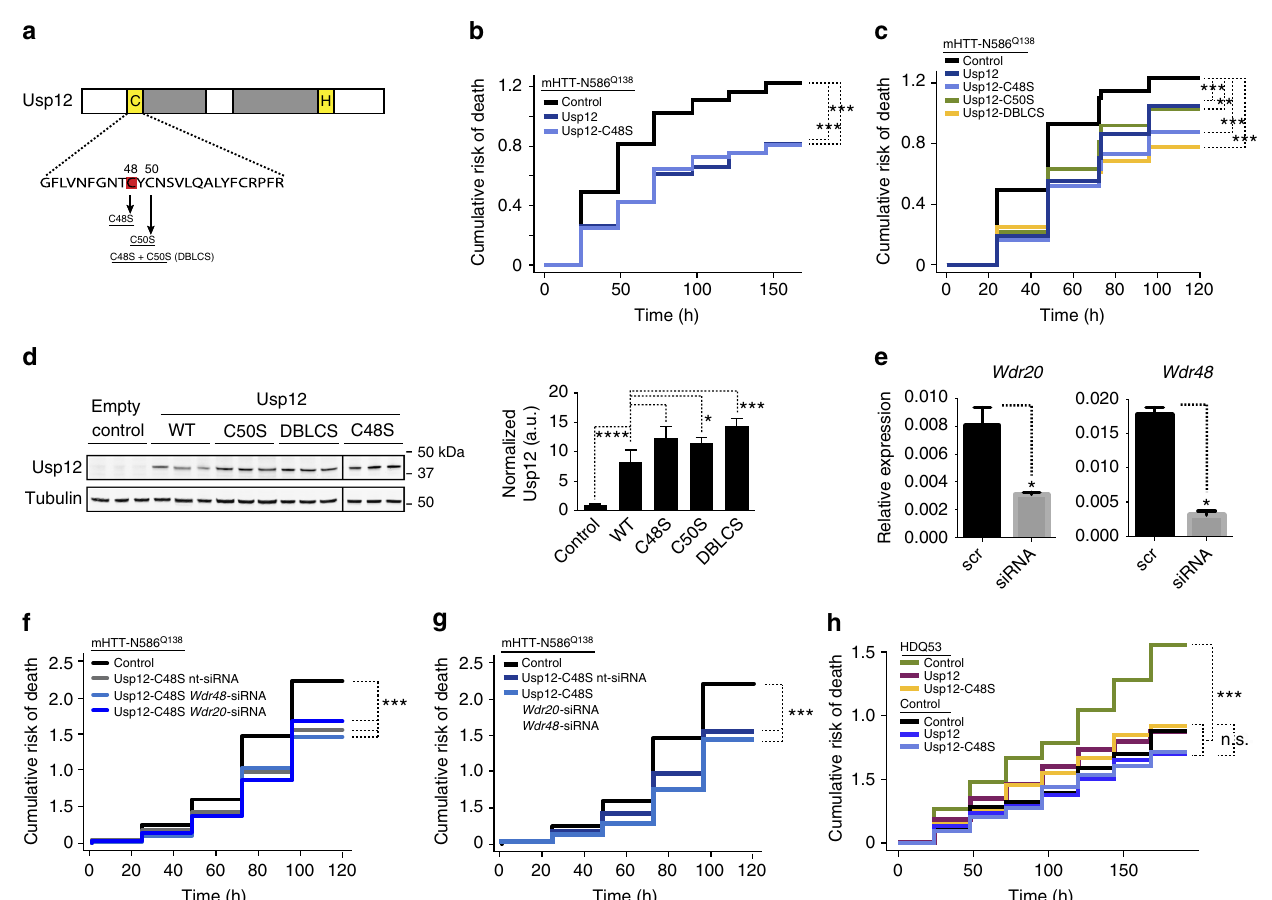
Fig. 4 Deubiquitinating activity of Usp12 is not required for suppression of mHTT toxicity. a Schematic representation of Usp12 domain structure. The conserved active-site cysteine (C48) is highlighted in red. b , c Cumulative risk of death plots for primary neurons co-transfected with mHTT-N568 Q138 and Usp12, Usp12 mutants that lack deubiquitinating activity in vitro (Usp12-C48S), or retain activity (Usp12-C50S), Usp12 containing both mutations (Usp12- DBLCS), or empty vector control; statistical data are summarized in Table 2. d Expression of Usp12 and Usp12 mutants in HEK cells transfected with these plasmids. Usp12-C48S samples are from a separate gel. Tubulin was assayed as a loading control, s.e. are shown. One-way ANOVA with multiple comparisons, **** p < 0.0001, *** p < 0.001, * p < 0.05. e Relative Wdr20 and Wdr48 mRNA levels of a rat C6 cell line transfected with Wdr20 and Wdr48 siRNAs, respectively. * p < 0.01, s.e.m. are shown. f , g Cumulative risk of death plots for primary neurons co-transfected with mHTT-N568 Q138 , Usp12-C48S, and siRNAs against either Wdr20 or Wdr48 ( f ) or both ( g ). HR was used to estimate the relative risk of death and results are summarized in Supplementary Table 6. h Survival analysis of human neurons differentiated from patient-derived iPSCs (unaffected individual, control; HD patient, HDQ53). Cox proportional hazards analysis was used to estimate the relative risk of death, or hazard ratio (HR), and the p value was determined with the